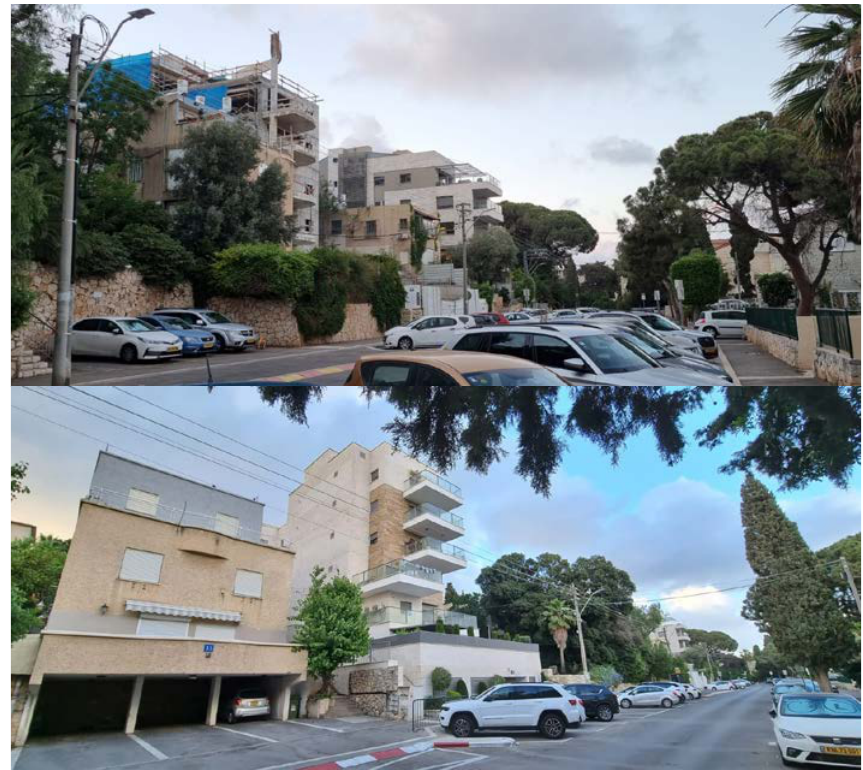
Figure 7. De-Israeli site, during the transformation of TAMA38 construction. A view from the inner side of the site. Photographed by the author, 2022.